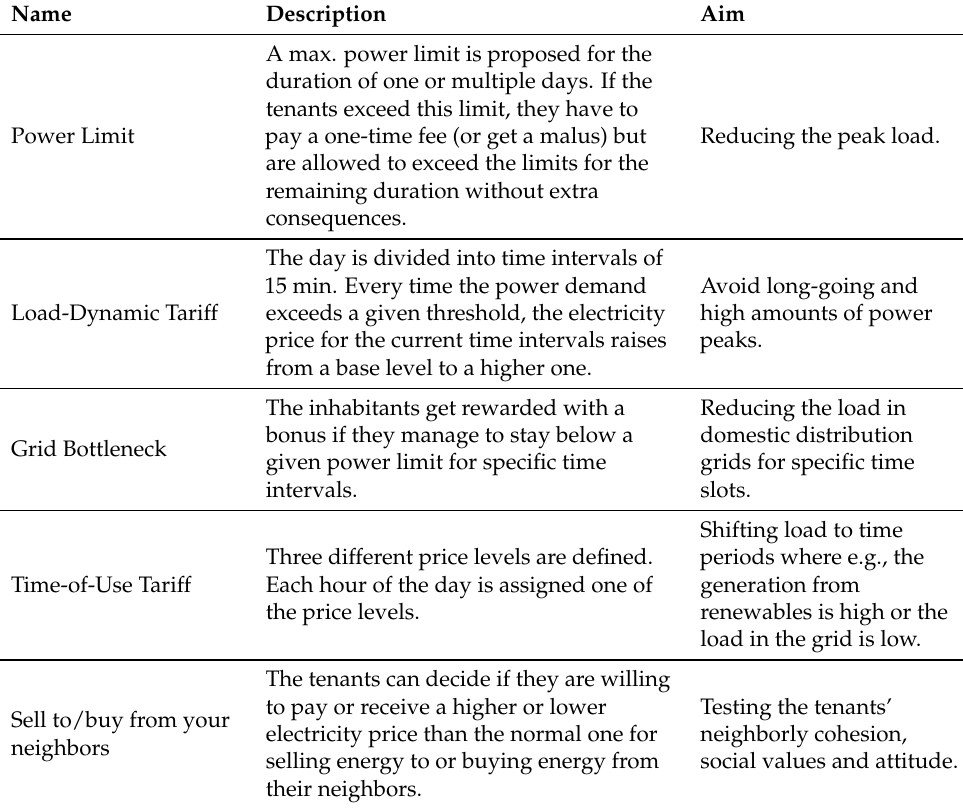
Table 1. Overview of the most important calls to action